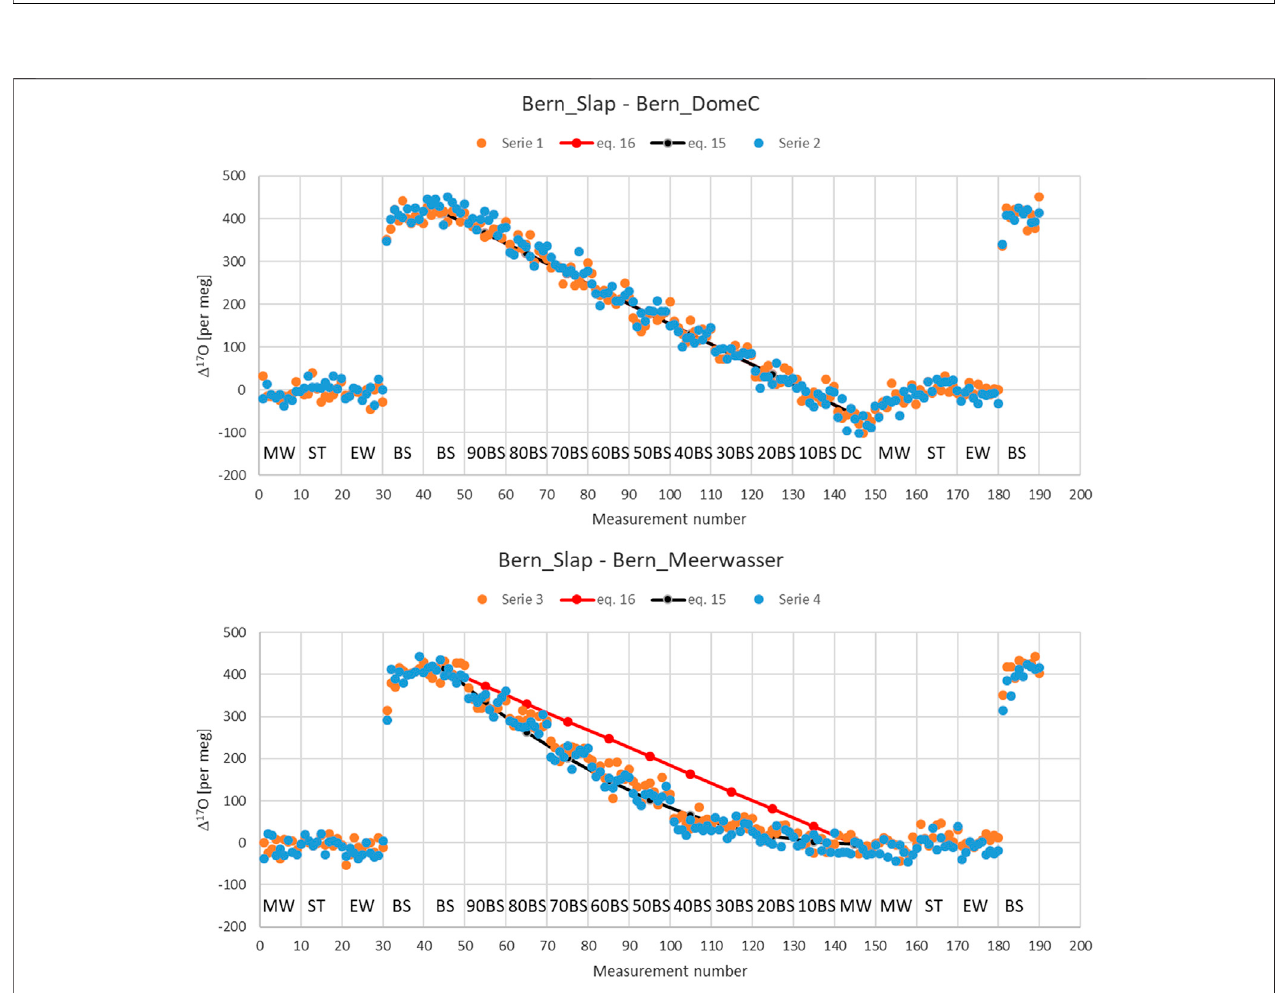
FIGURE2| Upperpanel,mixingseries(1and2)instepsof10%oftwostandardwaterwithdifferent Δ 17 Obutsimilar δ 18 Ovalues,i.e.Bern_Slap,BS(412permeg, -55.21 per mil) and Bern_DomeC, DC ( − 54 per meg, − 54.18 per mil). Lower panel: Mixing series (3 and 4) in steps of 10% of two standard water with different Δ 17 O as wellasdifferent δ 18 Ovalues,i.e.Bern_Slap,BS(412permeg, − 55.21permil)andMeerwasser,MW( − 3permeg, − 0.043permil). Δ 17 Oiscalculatedbasedon Eq.4 .ST (ST-08)andEW(Eiswasser)correspondtotwoadditionalstandardsforcalibrationpurposes.ThenumberbeforeBSneedtobereadas,e.g.90BSstandsfor90% BS and 10% DC (series 1 and 2) or MW (series 3 and 4), respectively.